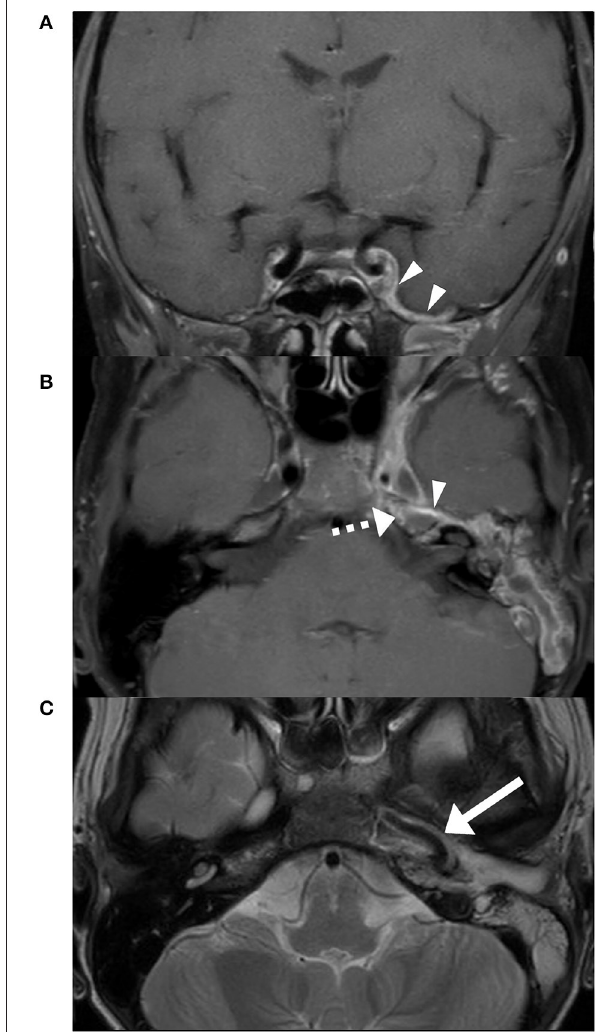
FIGURE 2 | Initial MRI T1 DIXON FS post gadolinium. Dural enhancement (triangles) in the area of the left temporal lobe (A) . Anteromedial rim enhancement of the opacified petrous apex (dashed arrow) (B) . Thrombotic cavernous sinus and a marked vasculitis of the internal carotid artery (arrow) on the left side (C)